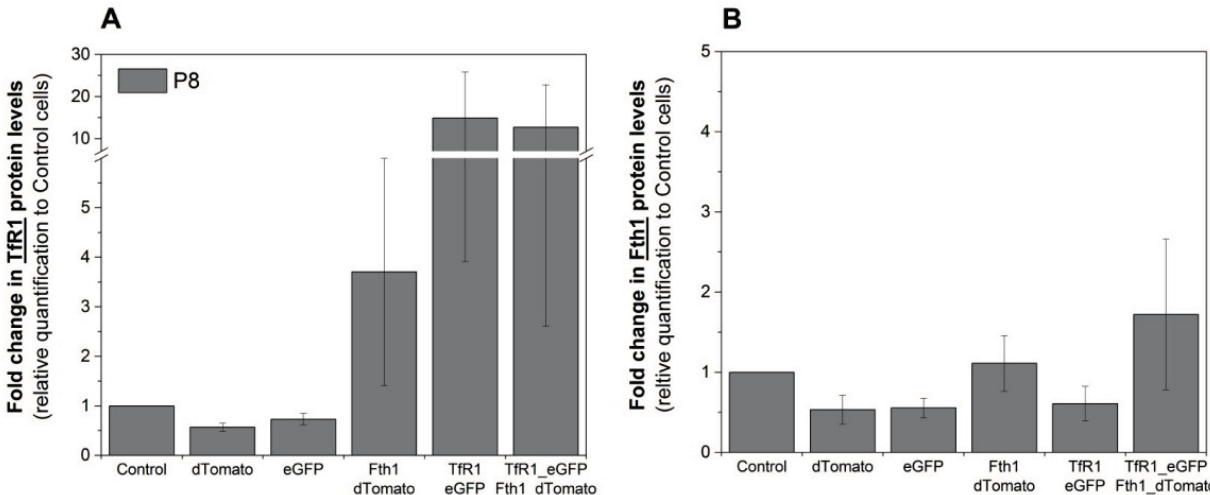
Figure 4. Relative quantification of the reporter proteins. Fold change in the intensity of ( A ) TfR1 or ( B ) Fth1 protein band. Protein levels are relative to the band intensity